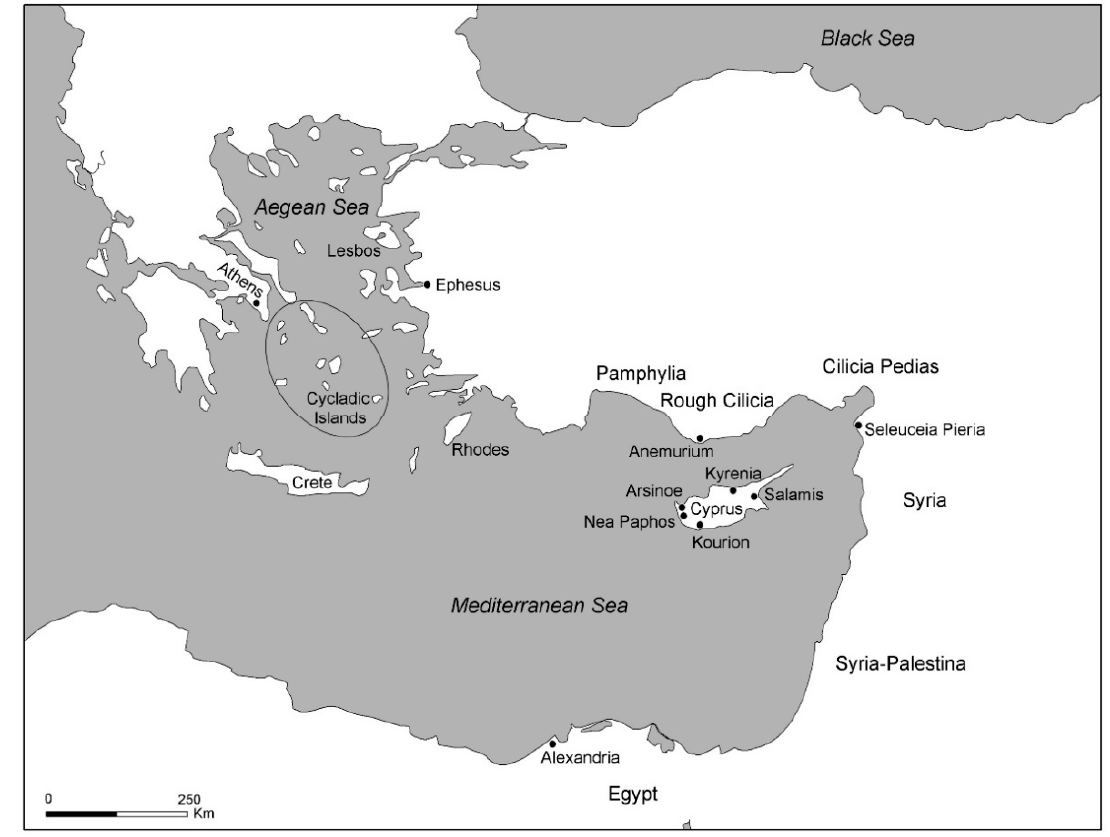
Figure 4. Map showing the location of Cyprus in the maritime world of the eastern Mediterranean during the Early Roman period. Map courtesy of Brandon Olson.